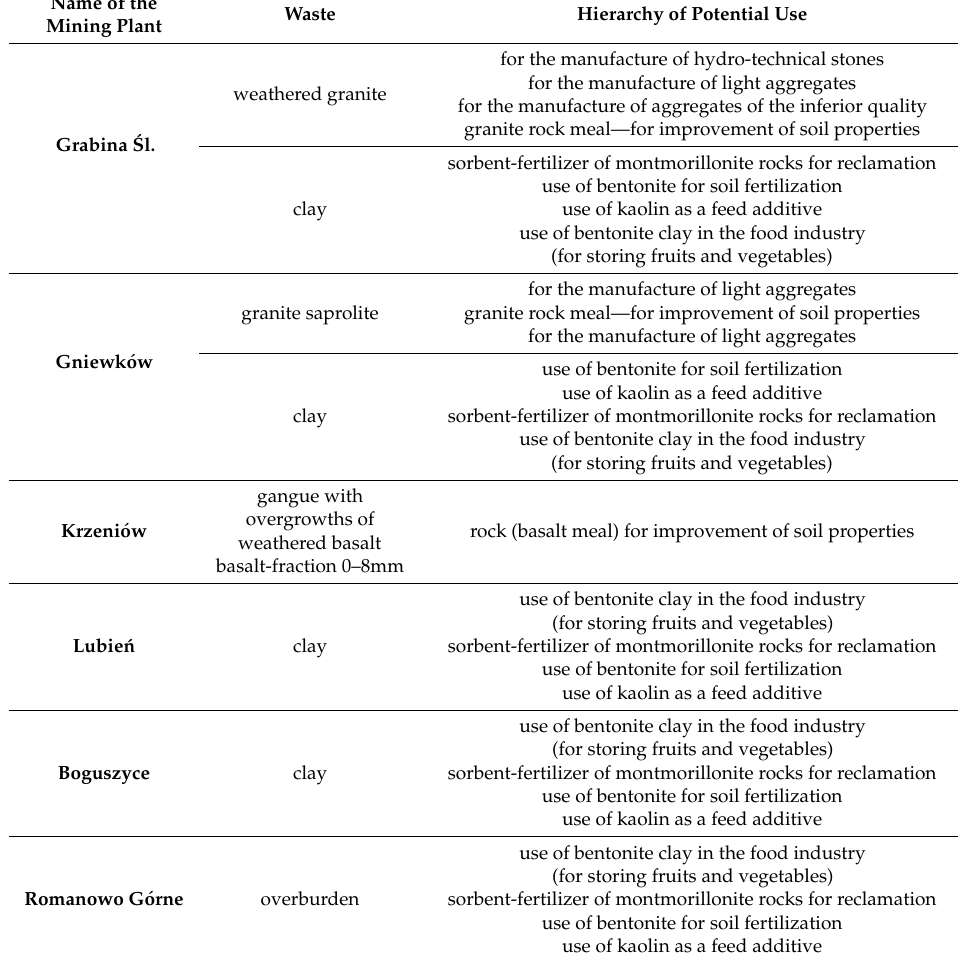
Table 5. Recommendations of potential possibilities for using waste regarding results of overall priority calculations and weights of local preferences with respect to potential waste